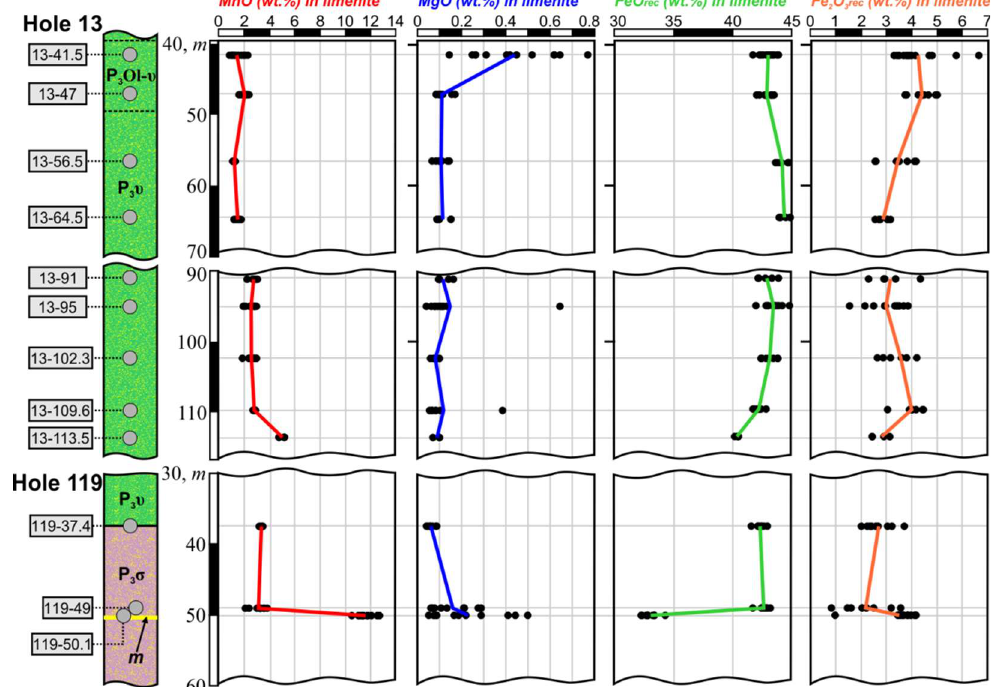
Figure 8. Variations of MnO, MgO, and recalculated FeO and Fe 2 O 3 (FeO rec and Fe 2 O 3rec , respectively) contents in ilmenite from the metamorphosed mafic-ultramafic rocks of the Sedova Zaimka intrusion,